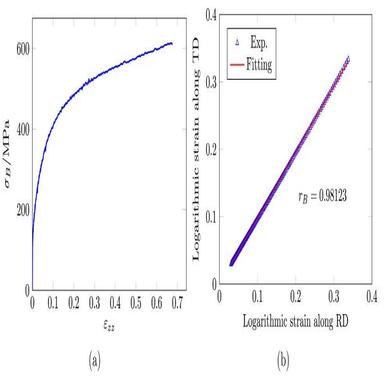
Hydraulic bulge test results for BH340: (a) logarithmic stress–strain curve in balanced biaxial loading, where zz indicates the through-thickness strain; (b) calculation of biaxial r-value.